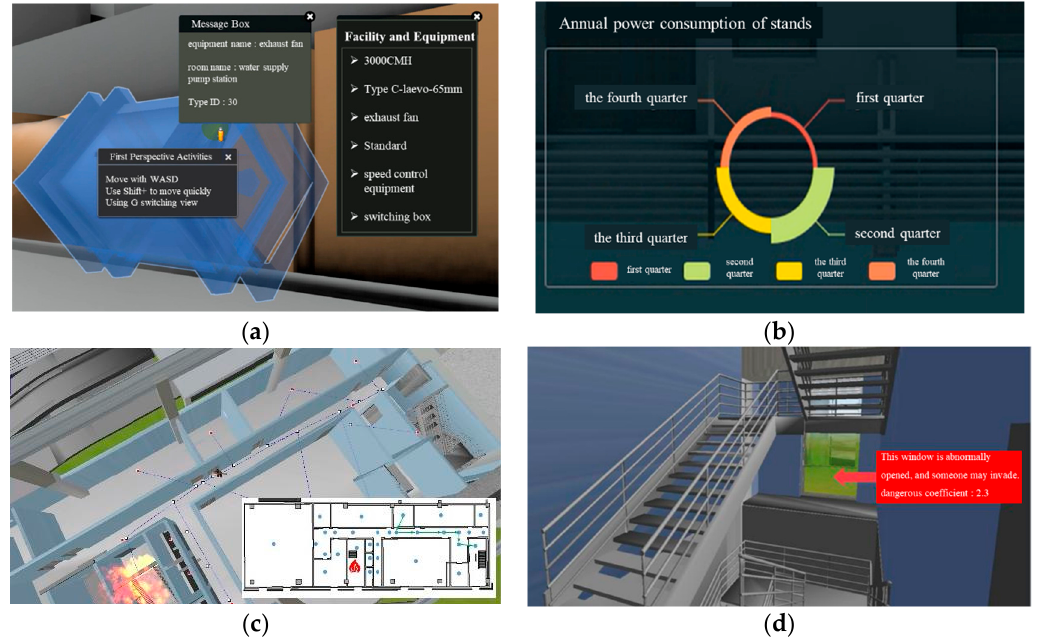
Figure 13. Application of intelligent building O&M technology system. ( a ) Equipment management system, ( b ) energy consumption monitoring system, ( c ) emergency treatment system, and ( d ) risk alarming system.